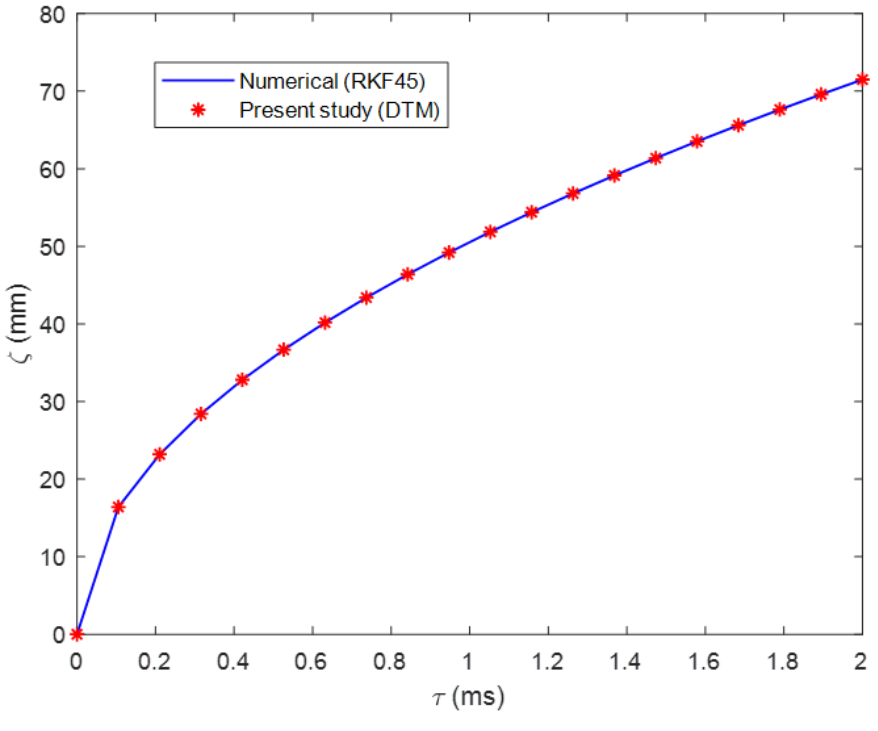
Figure 2. Verification of DTM with Numerical